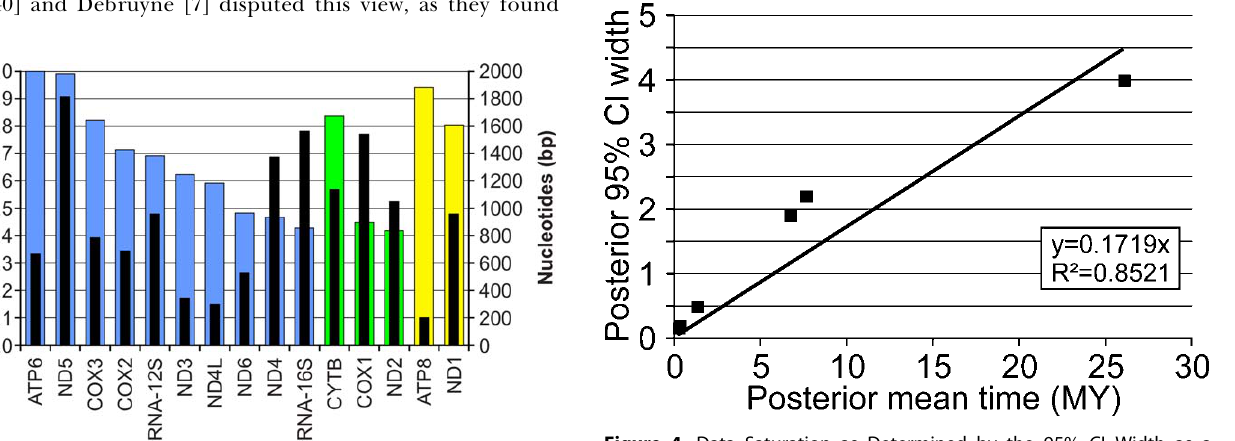
Figure 4. Data Saturation as Determined by the 95% CI Width as a Function of Posterior Mean Time The high correlation coefficient of this plot suggests that the sequence data are highly informative. However, it cannot be excluded that the accuracy of divergence time estimates could be further improved by additional sequence data. The graph corresponds to the whole genome analysis. The partitioned data give a slightly higher correlation coefficient of 0.89 (not